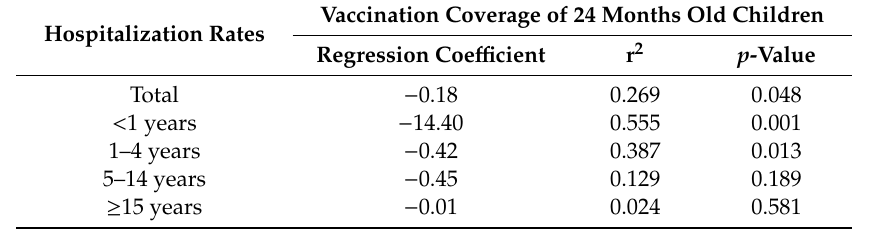
Table 2. Linear regression analysis between hospitalization rates × 100000 people and vaccination coverage of 24 months old children in Italy